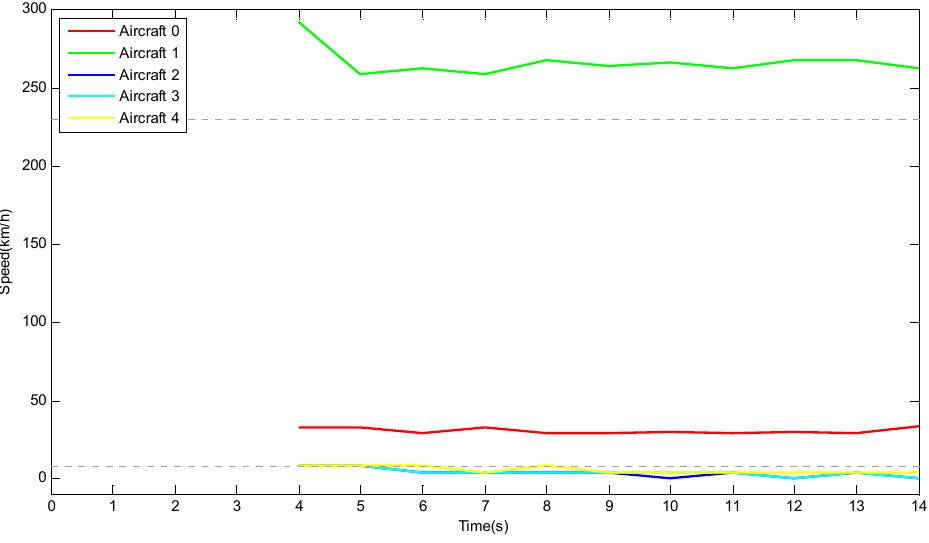
Figure 10. Speed measurements for each aircraft in test Video 1. Figure 11. Speed measurements for each aircraft in test Video